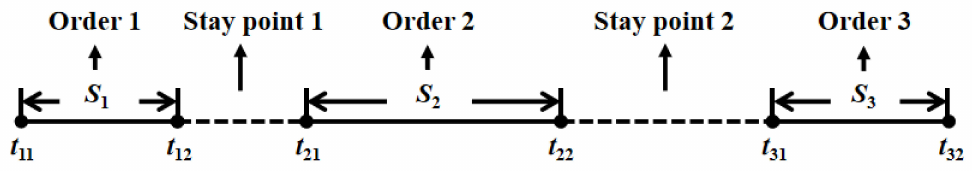
Figure 6. A car sharing order that has been split into three taxi suborders.